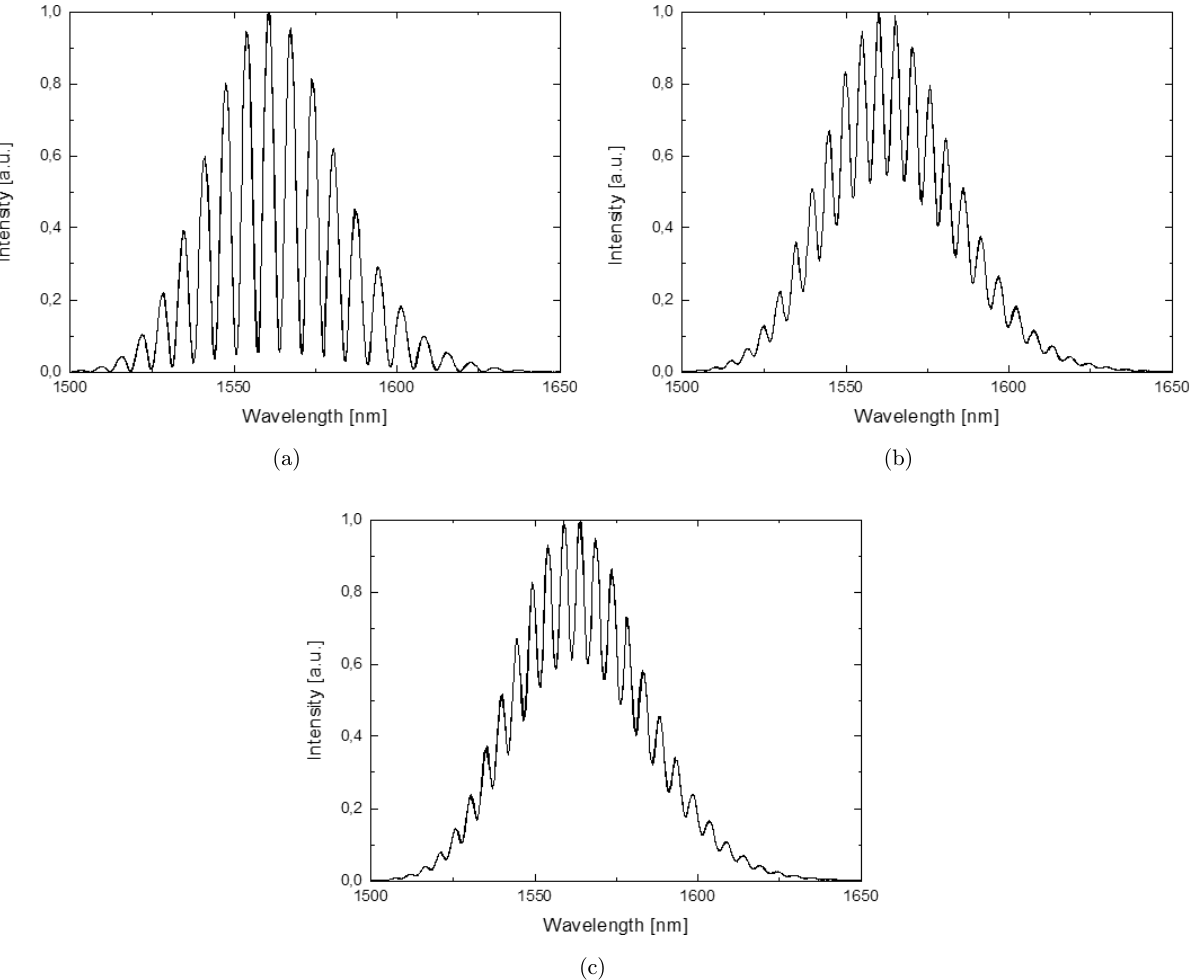
Fig. 5. Representative registered spectra for the central wavelength of 1550 nm: (a) reference measurement; (b) saline; (c)